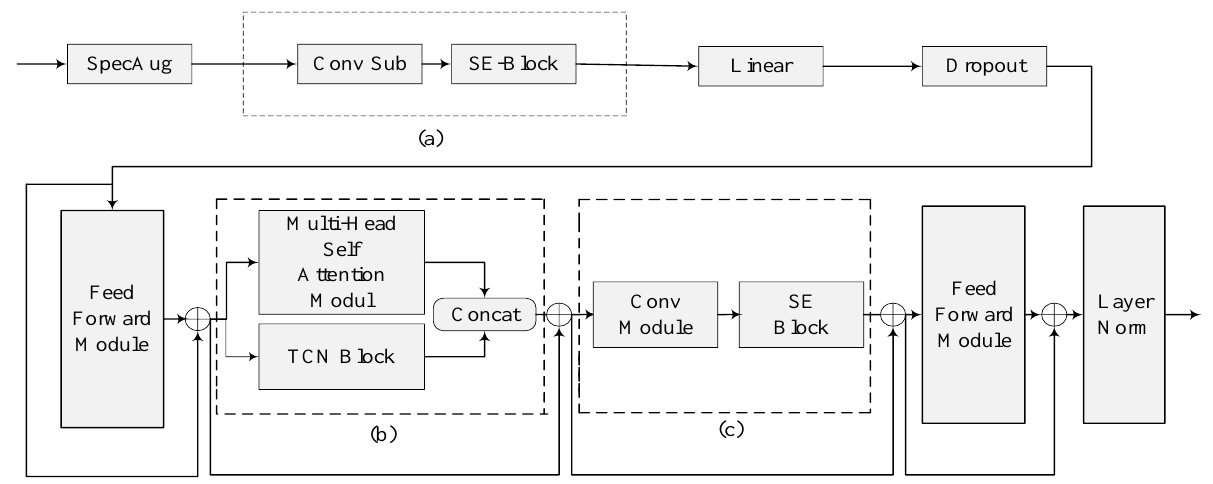
Figure 3. Architecture of proposed model. ( a ) First SE-Conv; ( b ) MHSA-TCN; ( c ) Second SE-Conv. The main differences between the SE-Conformer-TCN model architecture and the original Conformer model are the SE-Conv and MHSA-TCN substructures.